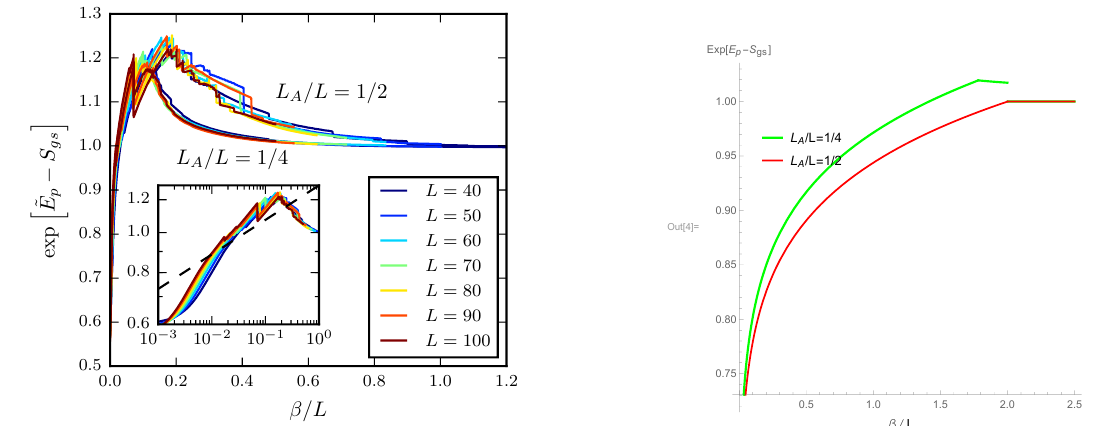
Figure 10. Left: the scaling form of the entanglement e ~ E p (cid:0) E gs = ~ f ( L A =L; (cid:12)=L ) for L A =L = 1 = 4 and 1 = 2, showing a collapse across di(cid:11)erent L . At (cid:12) , this approaches unity, consistent with ! 1 U anc completely disentangling the ancilla. The inset shows the same data on a log-log scale for L A =L = 1 = 2, and the dashed black line shows a c= 6 power-law slope (from Eq 3.15). Right: the scaling form from AdS/BCFT, with c = 1 = 2 (the Ising value). The Hawking-Page transition occurs at (cid:12)=L = 2. For very high temperatures, the E p surface drops vertically into the bulk. As (cid:12)=L increases, this surface can either exchange dominance with the one terminating on Q before the Hawking-Page transition (as is the case for L A =L = 1 = 4) or not (the case L A =L = 1 = 2). state as an upper bound (obtained by TEBD without disentangling) and half the mutual information as a lower bound (obtained via a thermal correlation matrix method [30]). We believe the noise is due to a landscape of local minima in the entanglement minimization step (see appendix C). ~ E p increases up to a maximum, before decreasing again and satu- rating the lower bound at high (cid:12) . Note that the saturation of the lower bound at (cid:12) ! 1 ~0 indicates that U anc has successfully transformed the ground state of the ancilla to an j i unentangled state, realizing the desired reduction (cid:31) TFD = (cid:31) 2 (cid:31) gs of the gs !